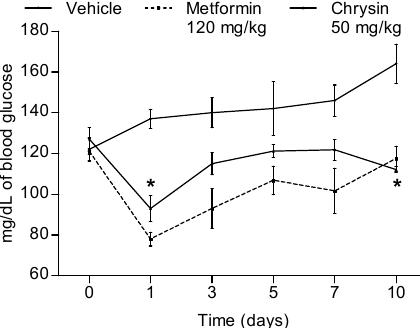
Figure 2. Antidiabetic effect of subacute intragastric administration of chrysin (50 mg/kg), metformin (120 mg/kg) and vehicle in streptozotocin–nicotinamide diabetic nude mice. Each plot represents the means ± SEM, n = 8; * p < 0.05.